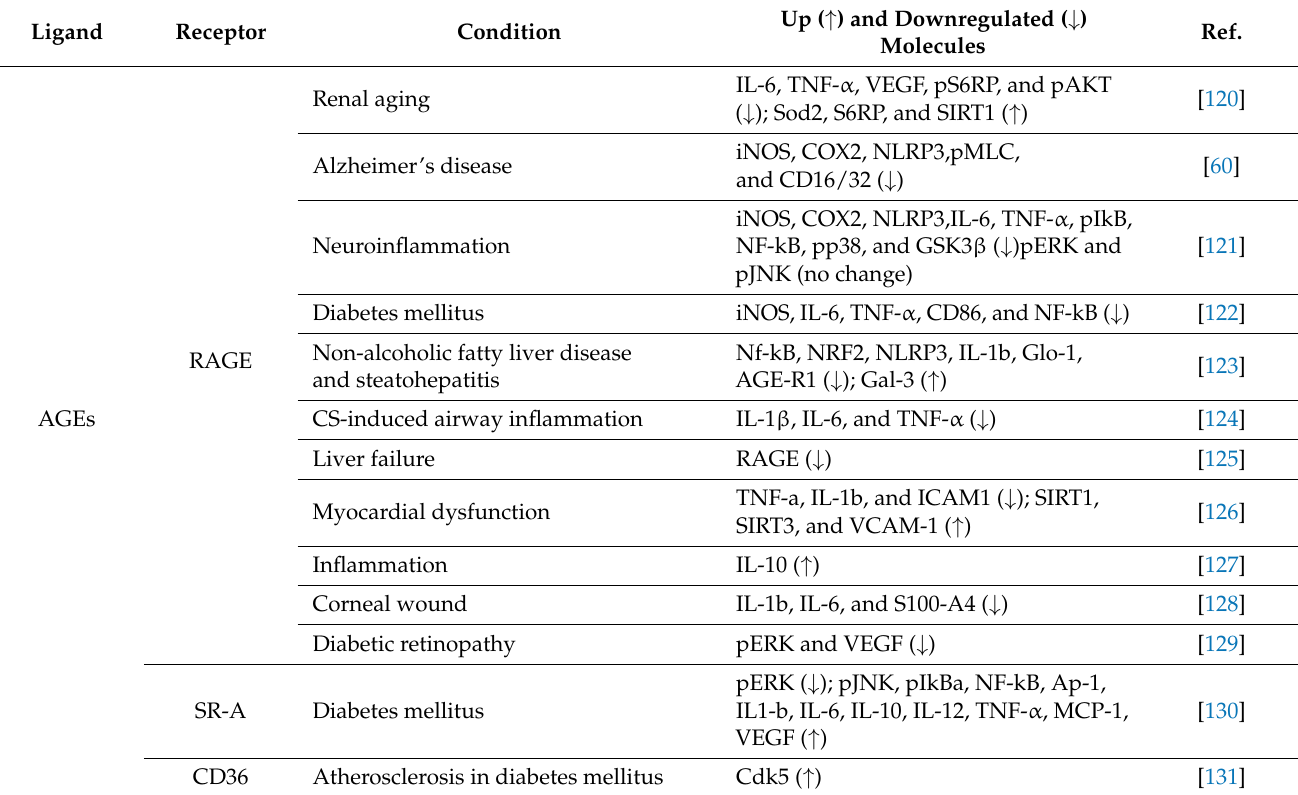
Table 1. Ablation of scavenger receptors of AGEs, AOPPs, and ALEs as therapeutic approaches for inflammatory